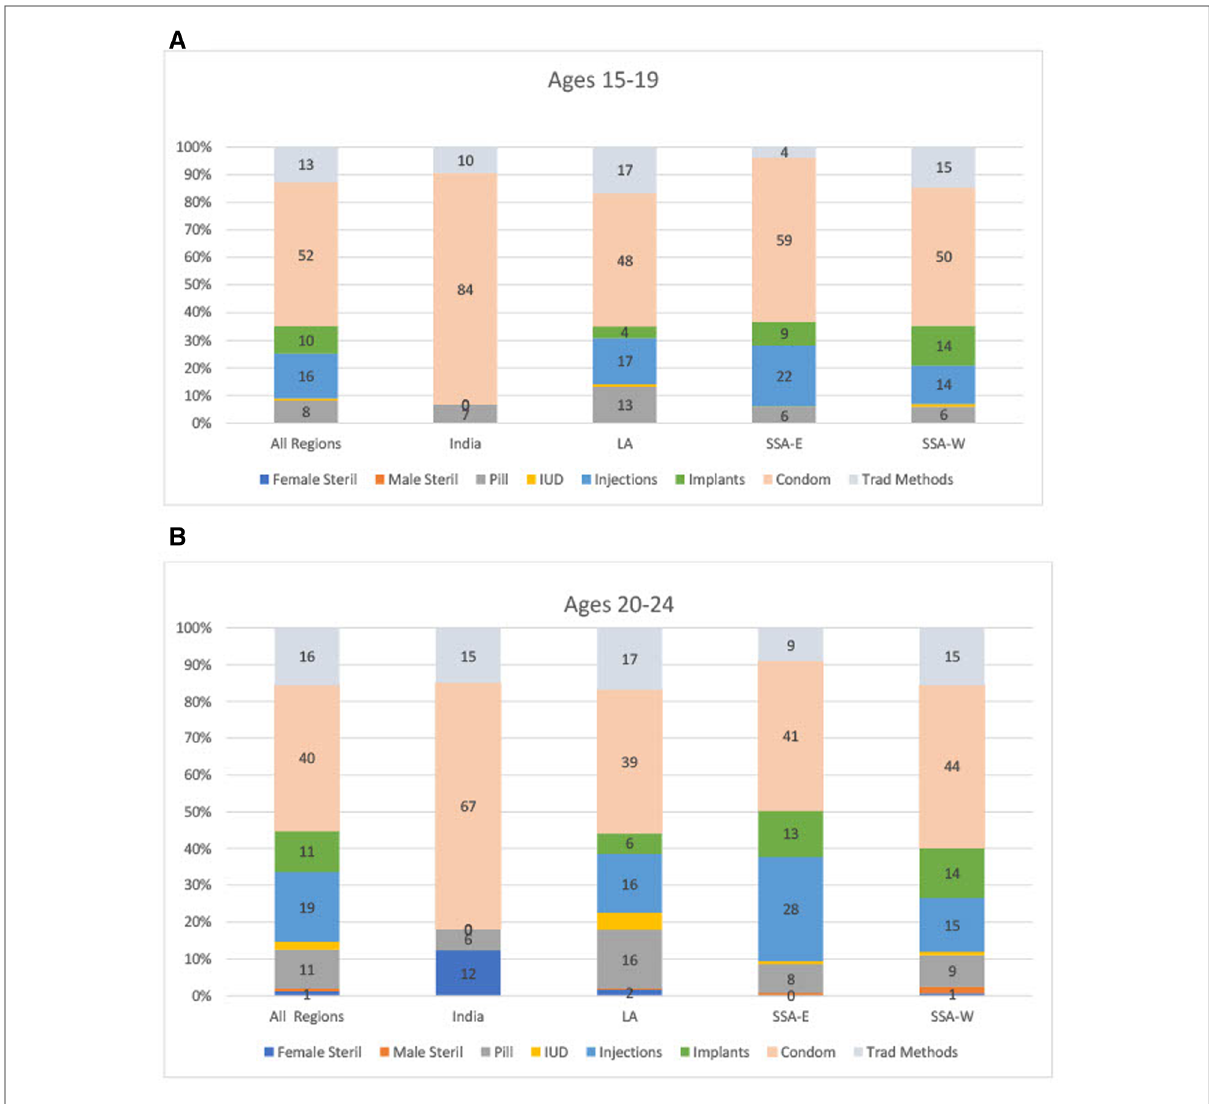
FIGURE 2 ( A , B ) method Mix for unmarried sexually active women, by Age and